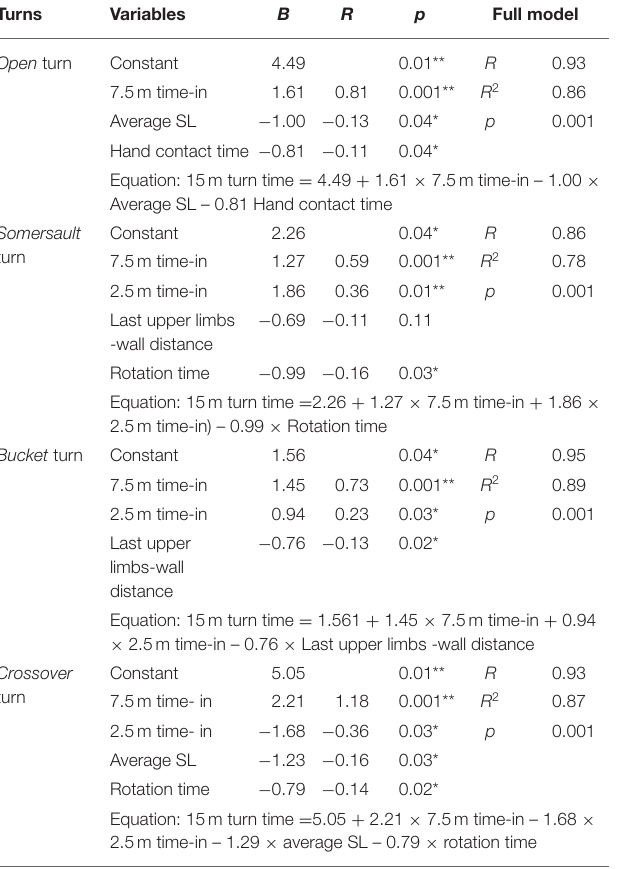
TABLE 4 | Data obtained from multiple regression analysis for turn-in variables. Turns Variables B R p Full model